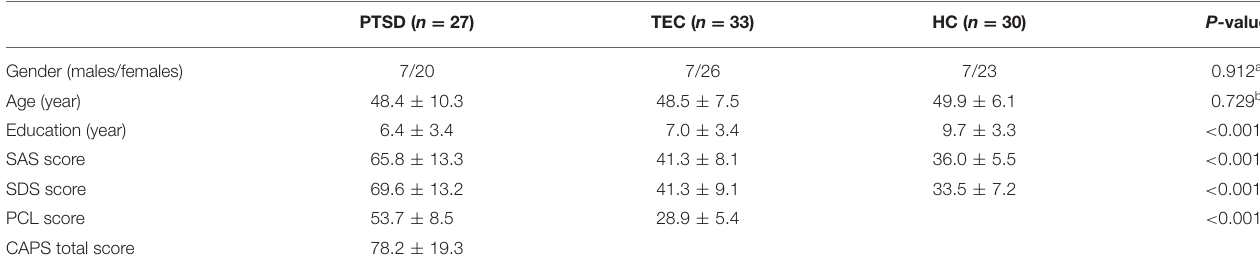
TABLE 1 | Demographic and clinical data of traumatized individuals and healthy